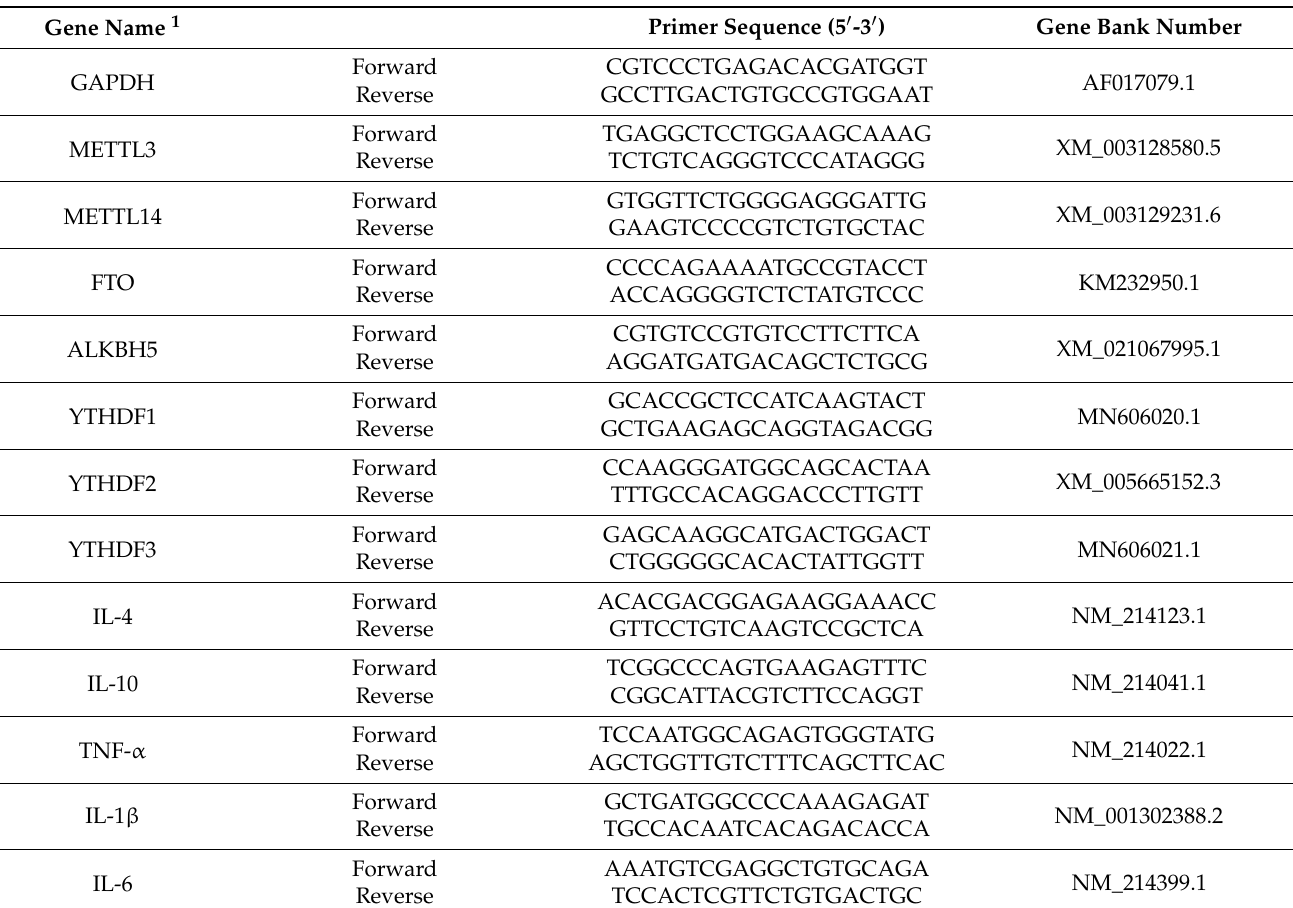
Table 1. Primer sequences used for quantitative real-time